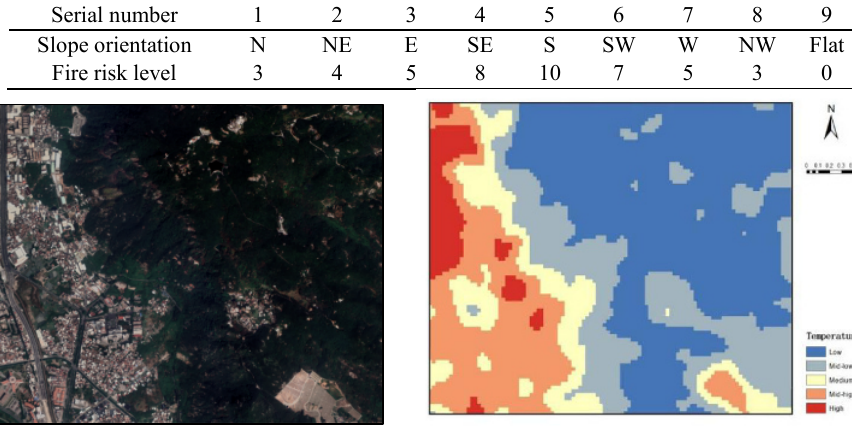
Fig. 1. Satellite map of the study area. Fig. 2. Temperature factor level.